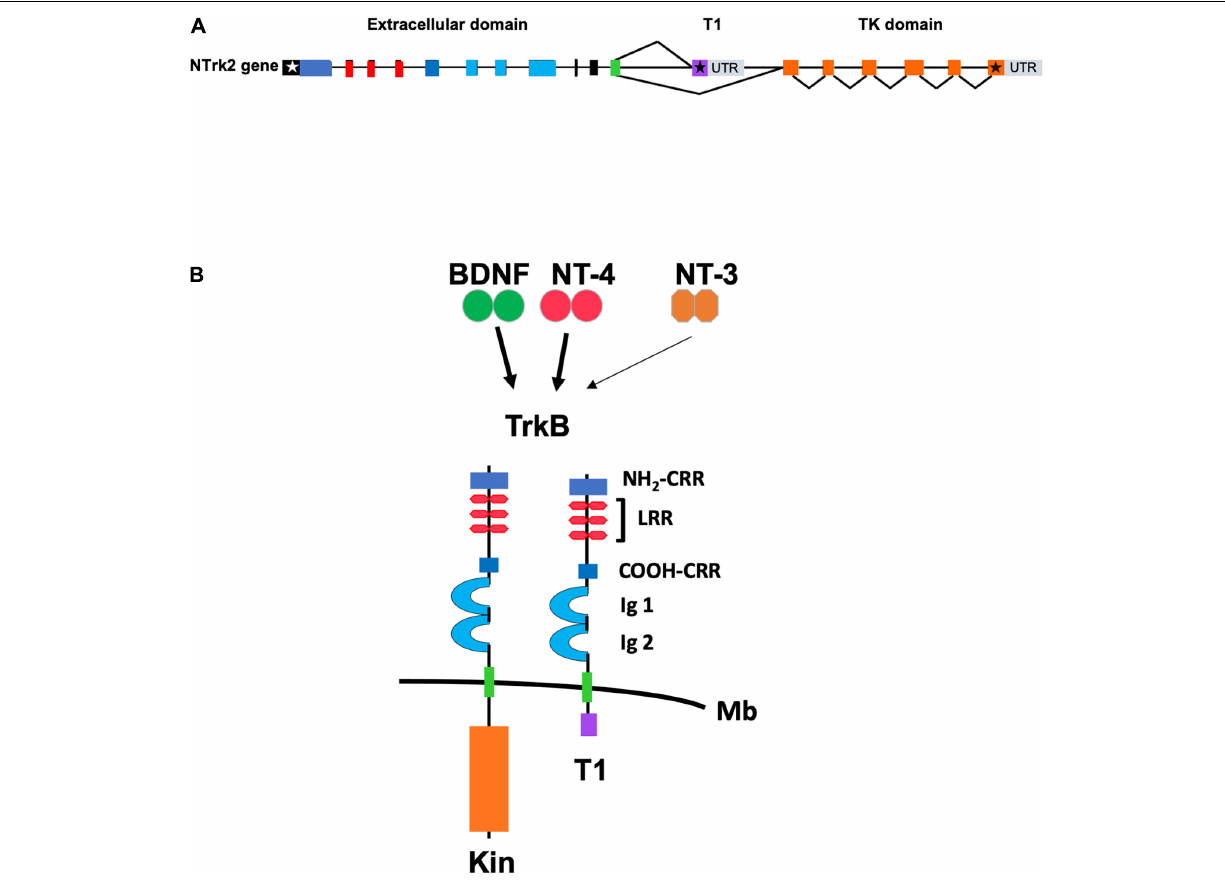
FIGURE 1 | (A) Schematic representation of the genomic structure of the murine TrkB gene. Exons are shown as boxes and introns are shown as lines. White and black stars indicate the start and stop condons, respectively. Color of exons indicate the domains of the TrkB protein isoforms shown in panel (B) . Gray boxes indicate the 3 (cid:48) untranslated region (UTR) of the TrkB transcripts. T1 and TK (Tyrosine Kinase) domain indicate the exons encoding, respectively, the TrkB.T1 and the TrkB.FL isoform that are produced by alternative splicing. (B) Schematic representation of the TrkB tyrosine kinase and TrkB.T1 isoform receptors. The extracellular TrkB protein domains include the amino (NH 2 -CRR) and carboxy (COOH-CRR) cysteine rich region; the leucine rich region (LRR) and the IG like, immunoglobulin like-domain (Ig1 and Ig2). The intracellular tyrosine kinase (Kin) and T1 domain are indicated below the cell membrane (Mb). BDNF and Neurotrophin-4 (NT-4) are the TrkB ligands binding with high affinity (solid arrow) whereas Neurotrophin-3 (NT-3) binds to the extracellular domain with lower affinity (thin